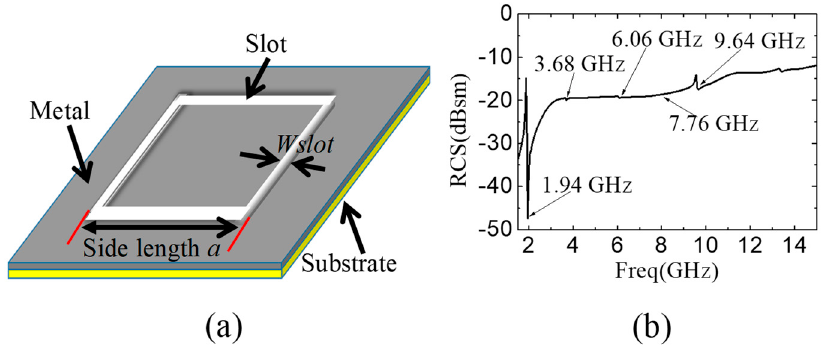
Figure 2. ( a ) Schematic of slot ring embedded on insulated substrate. The substrate is insulator, without any conductor on back side. ( b ) Spectrum of RCS of the single slot. The side length of rectangle a = 30 mm. The width of slot W slot = 0.5 mm. Its resonant frequency is 1.94 GHz.